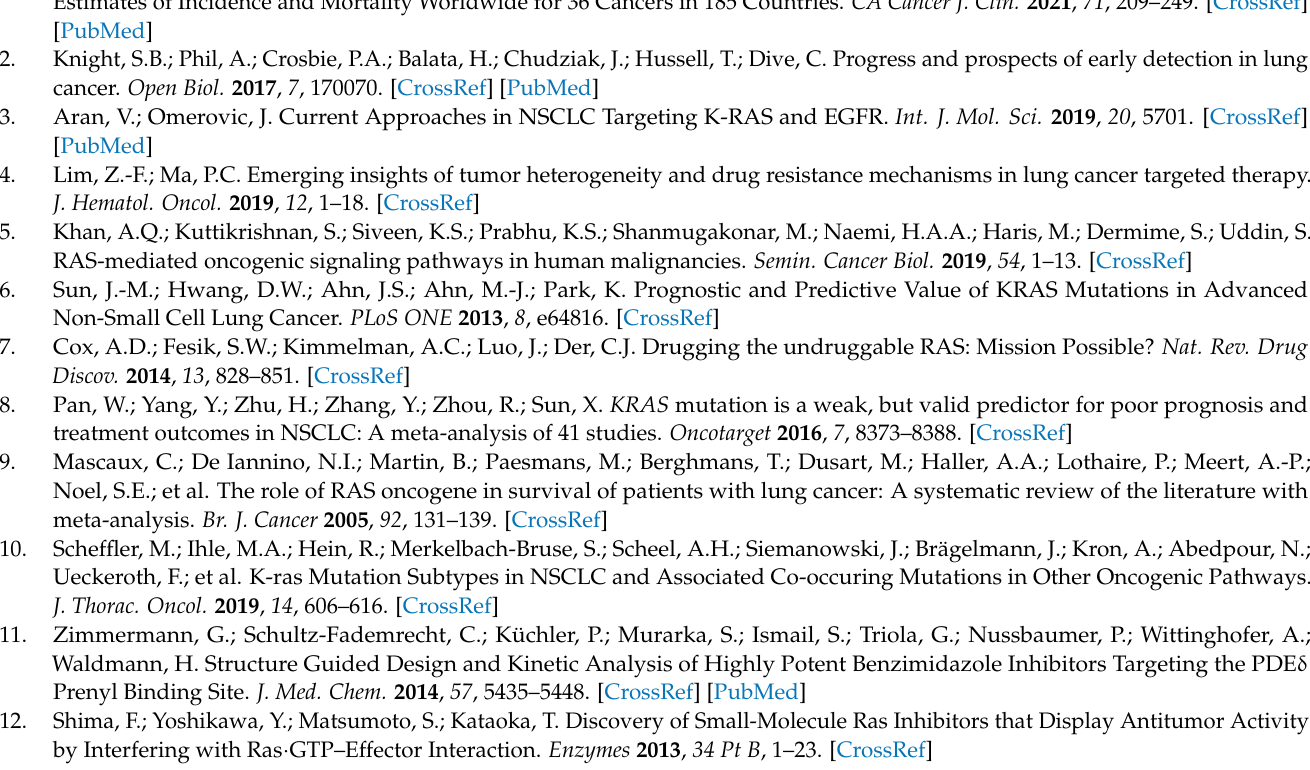
Figure S1. The chemical structures of the of the three RAS inhibitors: deltarasin (A), farnesylthiosal- icylic acid (B), Kobe0065 (C); Figure S2. An examples of the amplification curve plots for GAPDH (A), HRAS (B) and KRAS (C) genes including NTC and the melting curves of the real-time PCR amplification products of the GAPDH (D), HRAS (E) and KRAS (F) genes expressed as— ∆ RFU/ ∆ T vs. temperature; Figure S3. The examples of standard curve plots for GAPDH, KRAS and HRAS . (x-axis: log10 concentration of PCR product; y-axis—Ct